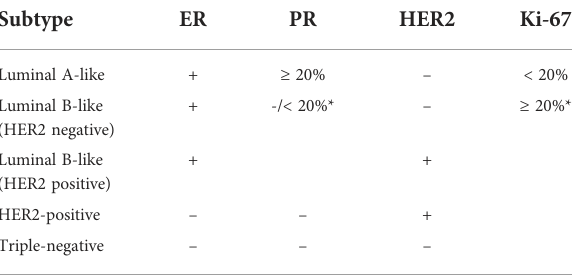
TABLE 1 Breast cancer molecular